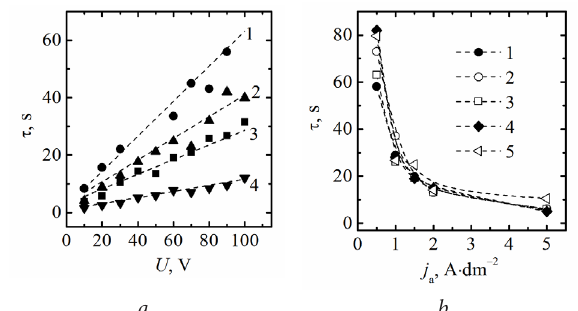
Fig. 3. Dependences of τ on voltage and current density during oxidation of the Ti6Al4V alloy: a – dependence of τ=f(U) at с А =10 g dm –3 and j a , А dm –2 : 1(1); 1,5(2); 2(3); 5(4); b – dependence τ=f(j a ) at U=40 V and с А , g·dm –3 : 5(1); 10(2); ∙ ∙ 25(3); 50(4); 100(5)